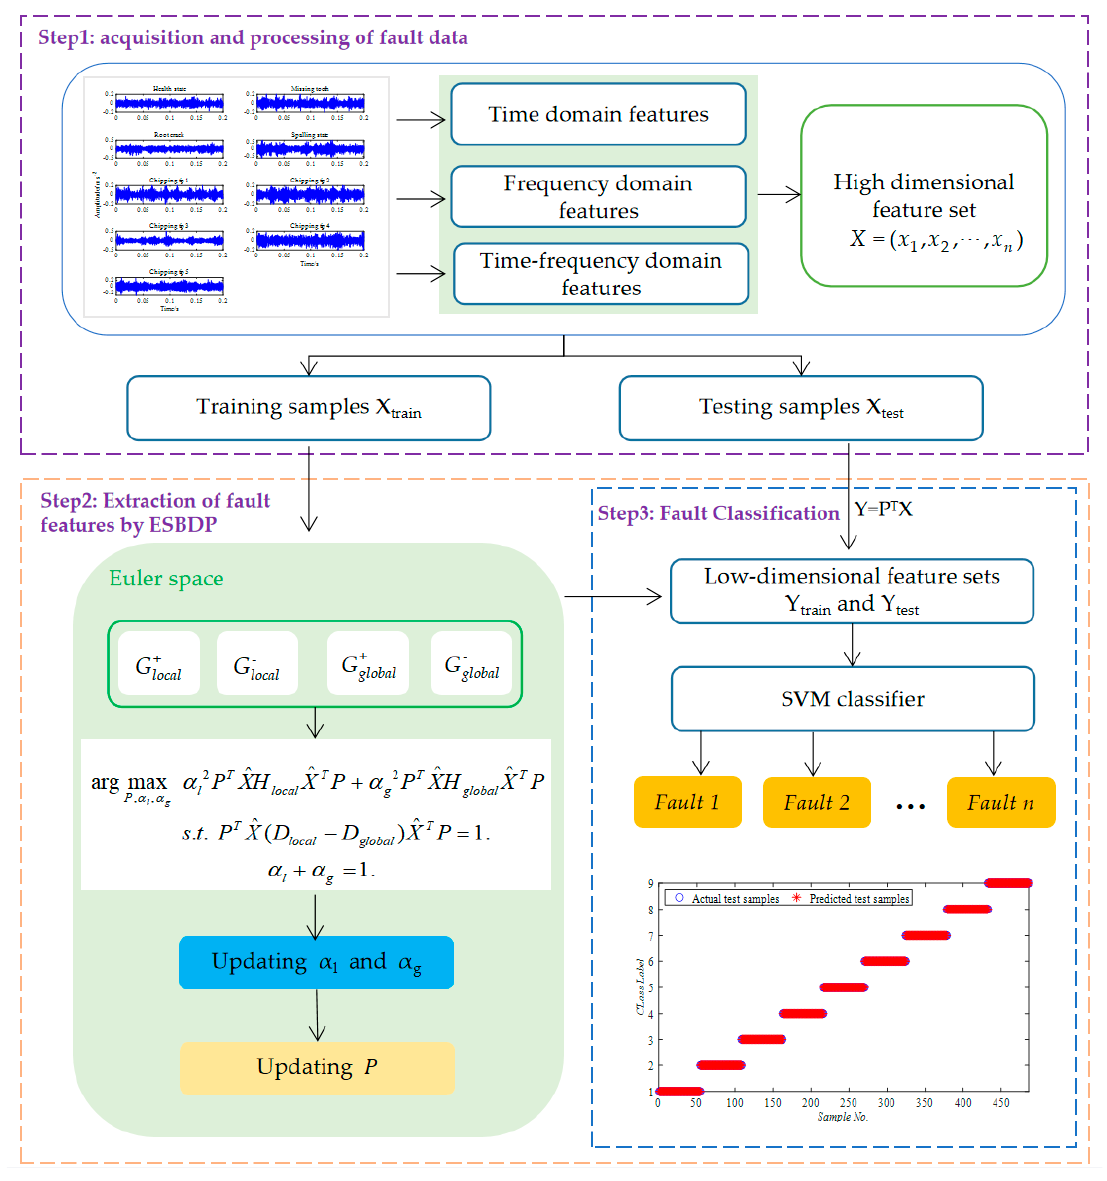
Figure 3. Procedure of fault diagnosis based on ESBDP. Table 2. Time–frequency characteristic